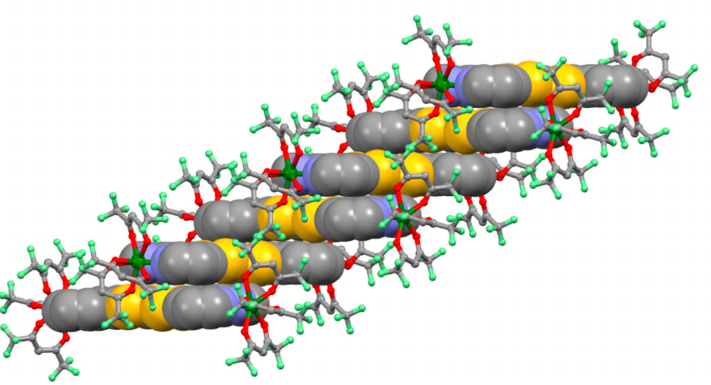
Figure 2. Crystal packing of ( 1 ) · 2(C 7 H 16 ) highlighting the 1D stacking of L (spacefill representation). The Yb(hfac) 3 units are represented by balls and sticks.